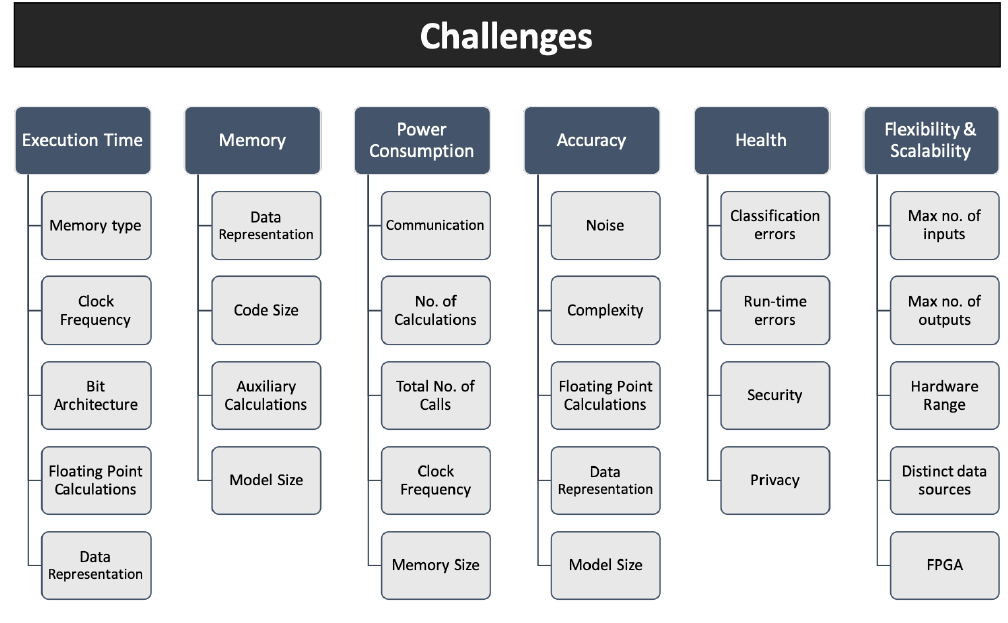
Figure 6. ML in embedded systems major challenges. The challenges can be grouped into six major groups: execution time; memory; power consumption; accuracy; health; flexibility and